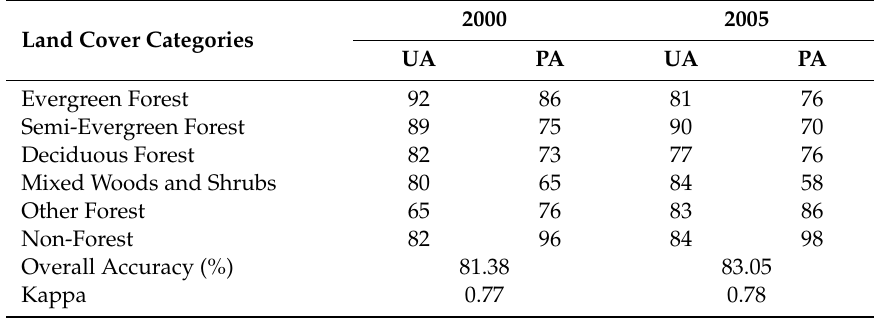
Table 6. Classification accuracy (%) for PBTC maps using reference land cover data in 2000 and